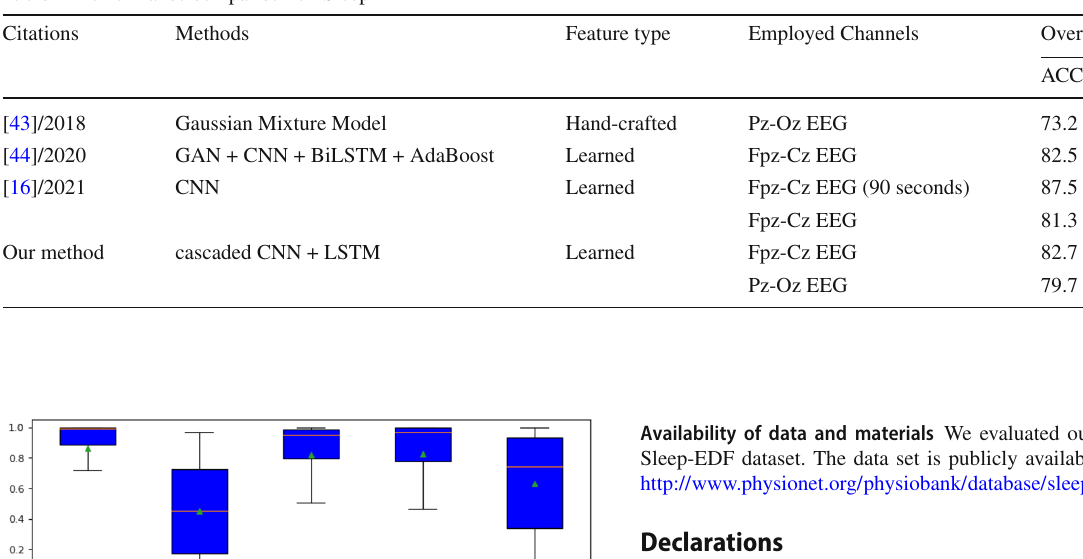
Table 7 Performance comparison on Sleep-EDF